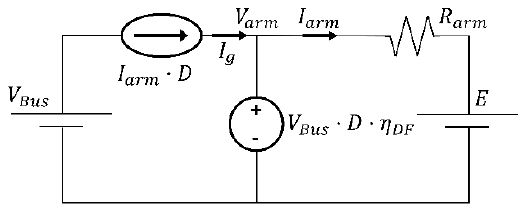
Figure 21. The steady-state equivalent circuit of the motor drive-electric motor-vehicle system. Equations (56) and (57) are obtained from the static circuit of Figure 21.